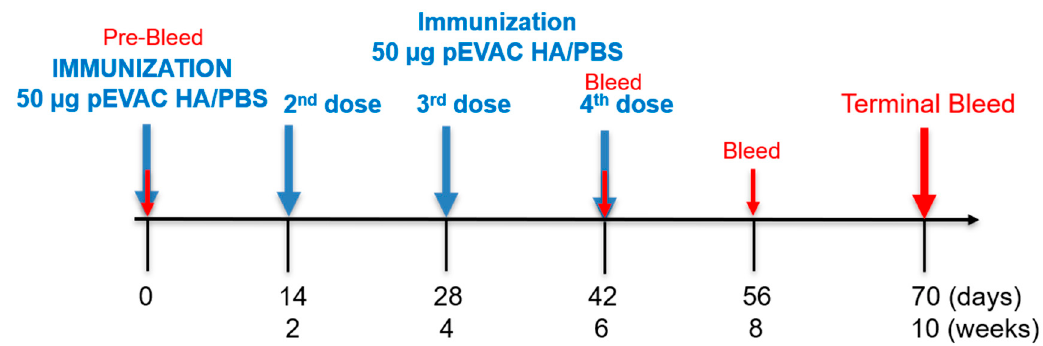
Figure 1. Study schedule of immunization with pEVAC HA antigens. Mice received either pEVAC HA antigens or PBS (negative control groups) on weeks 0, 2, 4, and 6 via subcutaneous rear flank injection. Blood was collected on weeks 6, 8, and 10.